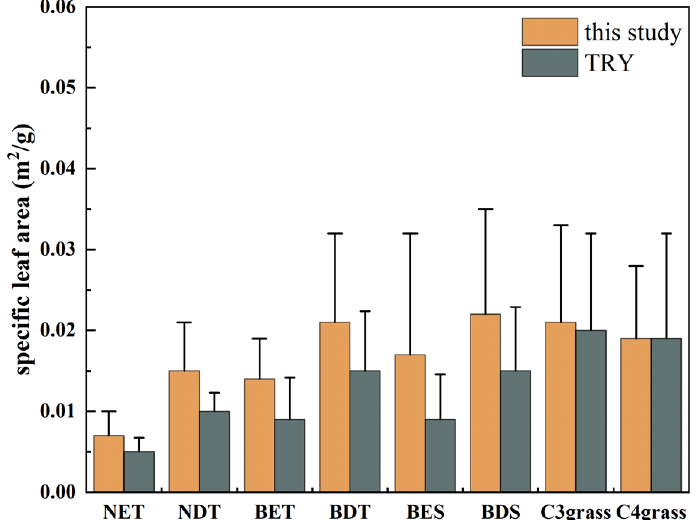
Figure 6. The differences in SLA values between the observation data in China and the global average in the TRY database. The error bar shows the standard deviation. Abbreviations: NET, needleleaf evergreen tree; NDT, needleleaf deciduous tree; BET, broadleaf evergreen tree; BDT, broadleaf deciduous tree; BES, broadleaf evergreen shrub; BDS, broadleaf deciduous shrub.